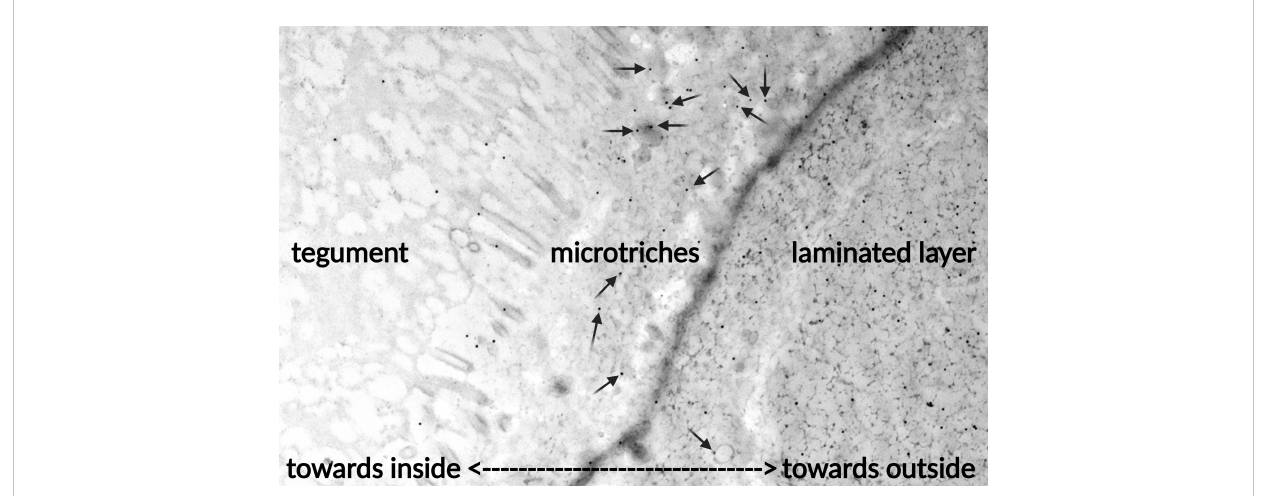
FIGURE 3 Transmission electron microscopy (TEM) of mAb EmG3 IgG1 on extracellular vesicles (EVs) of E. multilocularis in vitro vesicles. Arrows: Nano-gold labelling of the mAb EmG3 IgG1 con fi rms the binding to exosomes or EVs in the border of the laminated layer to the tegument and towards the inside of the vesicles and vesicle fl